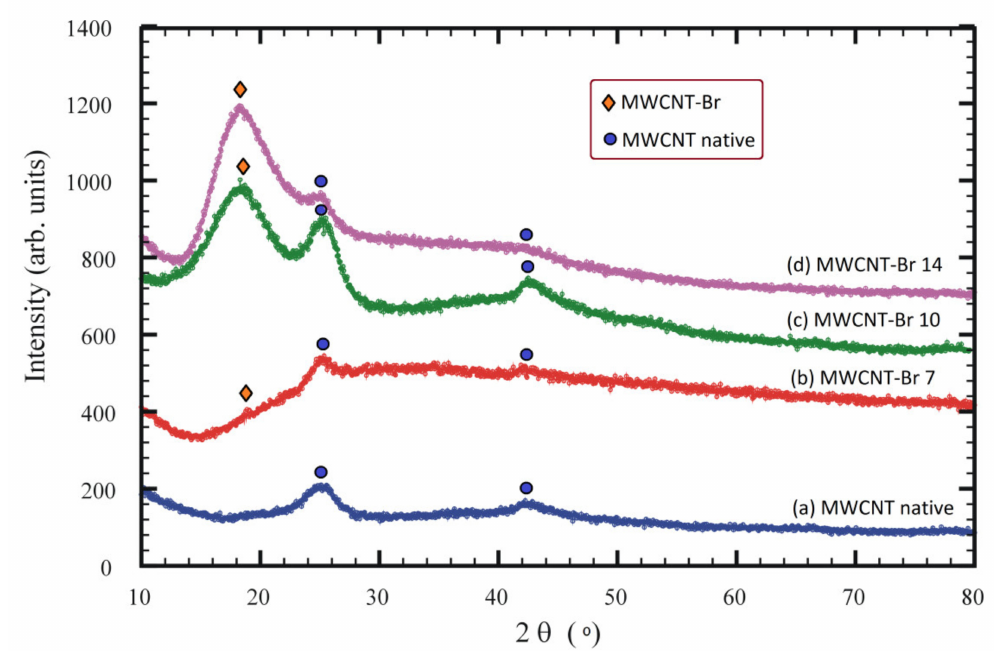
Figure 6. XRD patterns of native ( a ) and brominated MWCNT ( b – d ). The positions of diffraction peaks are marked as blue circles for native and orange rhombuses for brominated MWCNT, respectively.